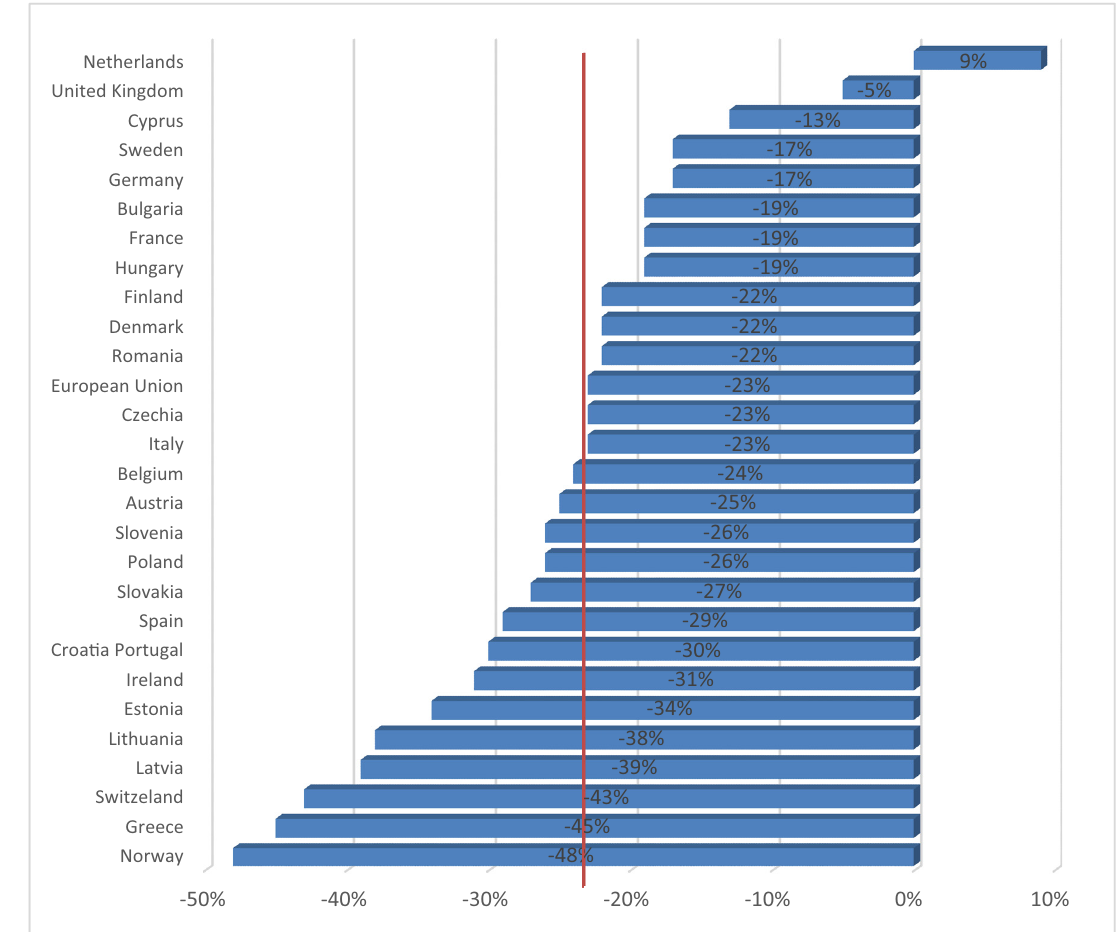
Figure 1: Reduction of road fatalities in 2010 – 2019. Source: “ authors ” elaboration based on ref. [ 3 ] .